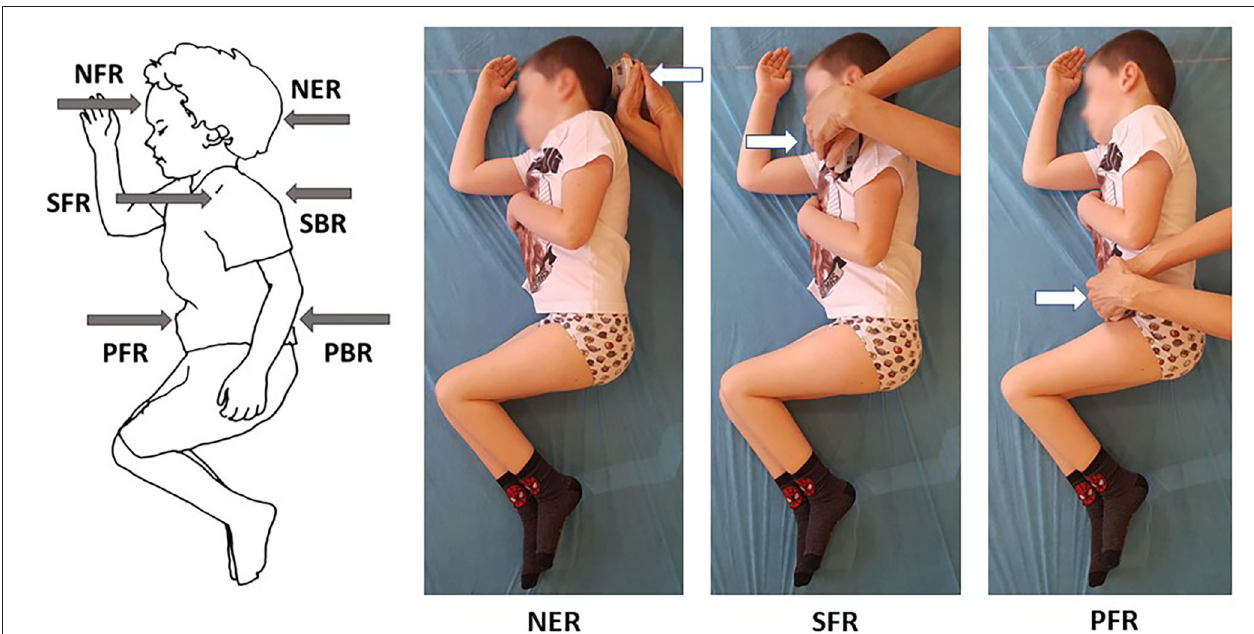
FIGURE 1 | Selected measurements of neck and trunk muscle strength in side lying on the right in a 6-year-old with type 3 SMA.